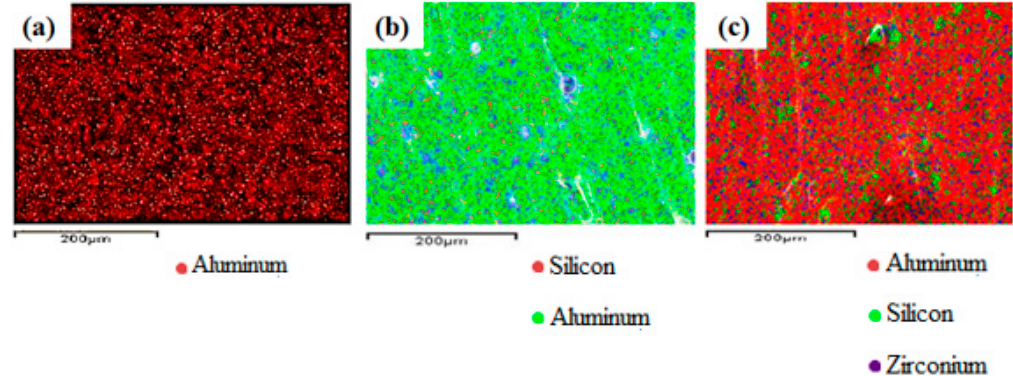
Figure 2. EDS results of ( a ) PP-1 ; ( b ) PP-3 ; ( c ) PP-4 .